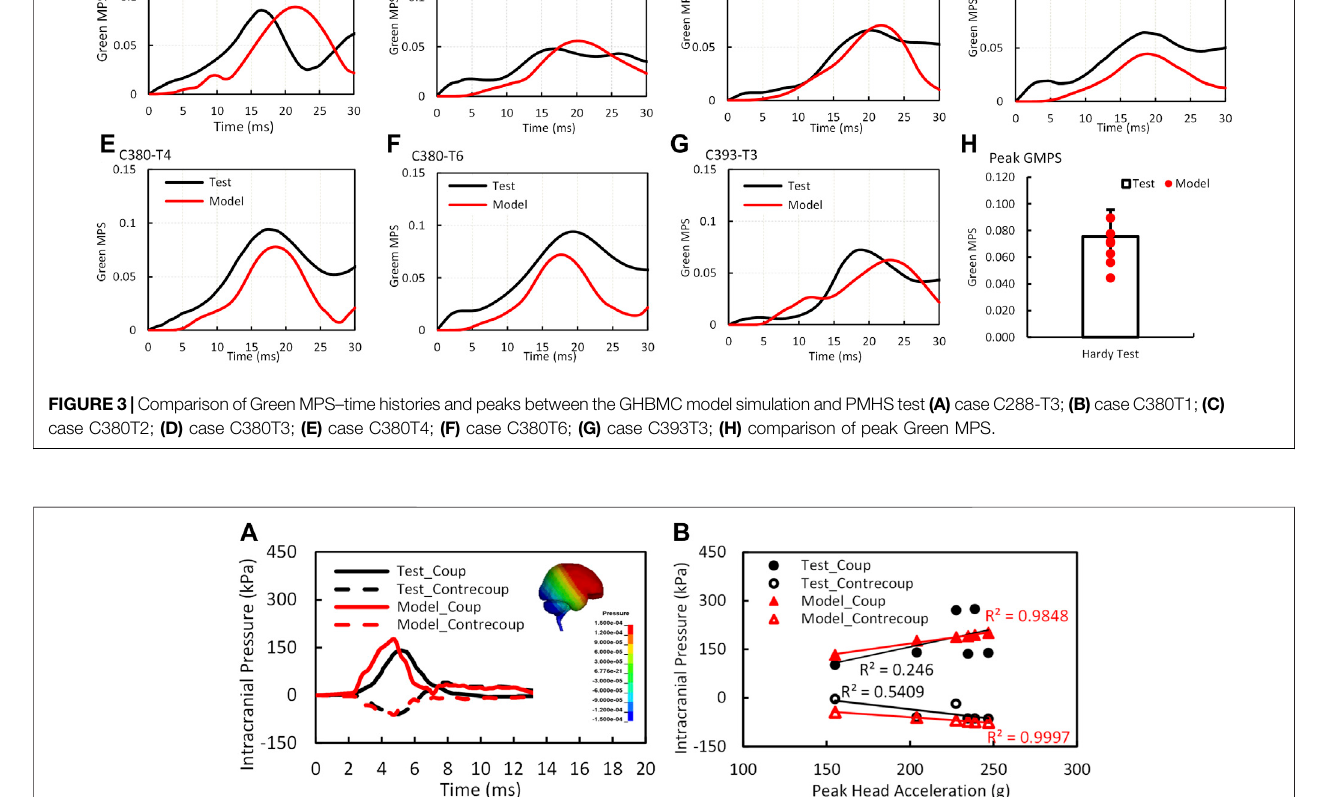
FIGURE 4 | (A) The intracranial pressure validation results at coup and contrecoup sites for test 37 (Nahum et al., 1977); (B) the relation of intracranial pressures and peak head accelerations ( n = 6).